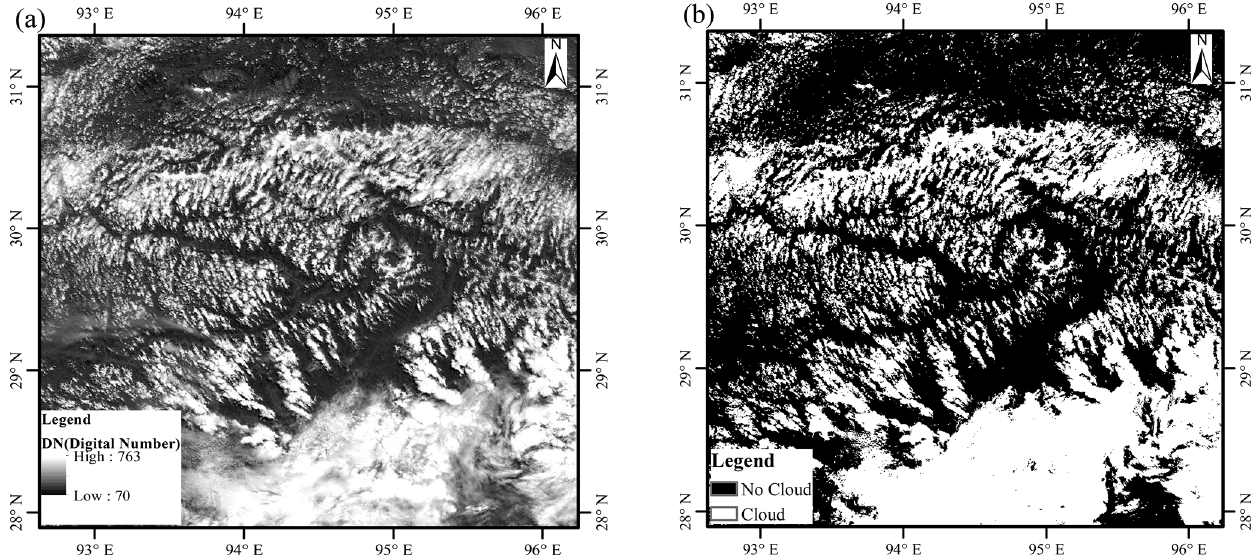
Figure 1. The (a) digital number (DN) and (b) spatial distribution of cloud in the southeastern TP from the geostationary earth observation satellite Gaofen 4 (GF 4) at 12:00 Beijing time (about 10:20LT) on 4 August 2020. Here we simply use DN = 250 as a threshold. All the grids in panel (a) are divided into two classes (DN > 250, cloud; DN < 250, no cloud), and then we give panel (b) .